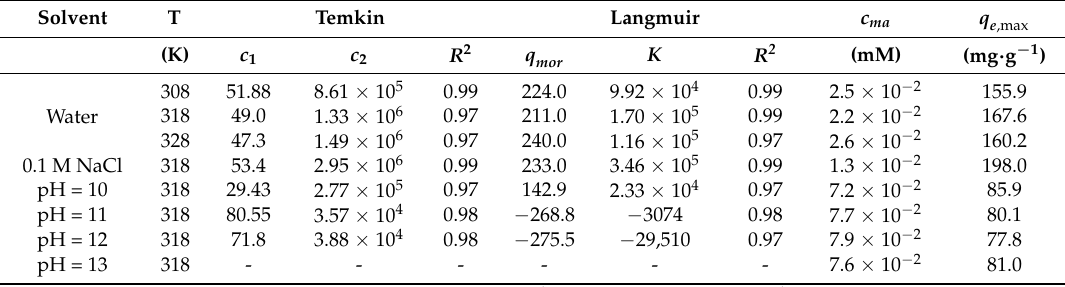
Table 3. The c ma and q e ,max values and parameters obtained from the Temkin and Langmuir equations for adsorption of CR on GO/PAMAM in section IIB in water, 0.1 M NaCl, and alkaline solutions at 308–328 K.